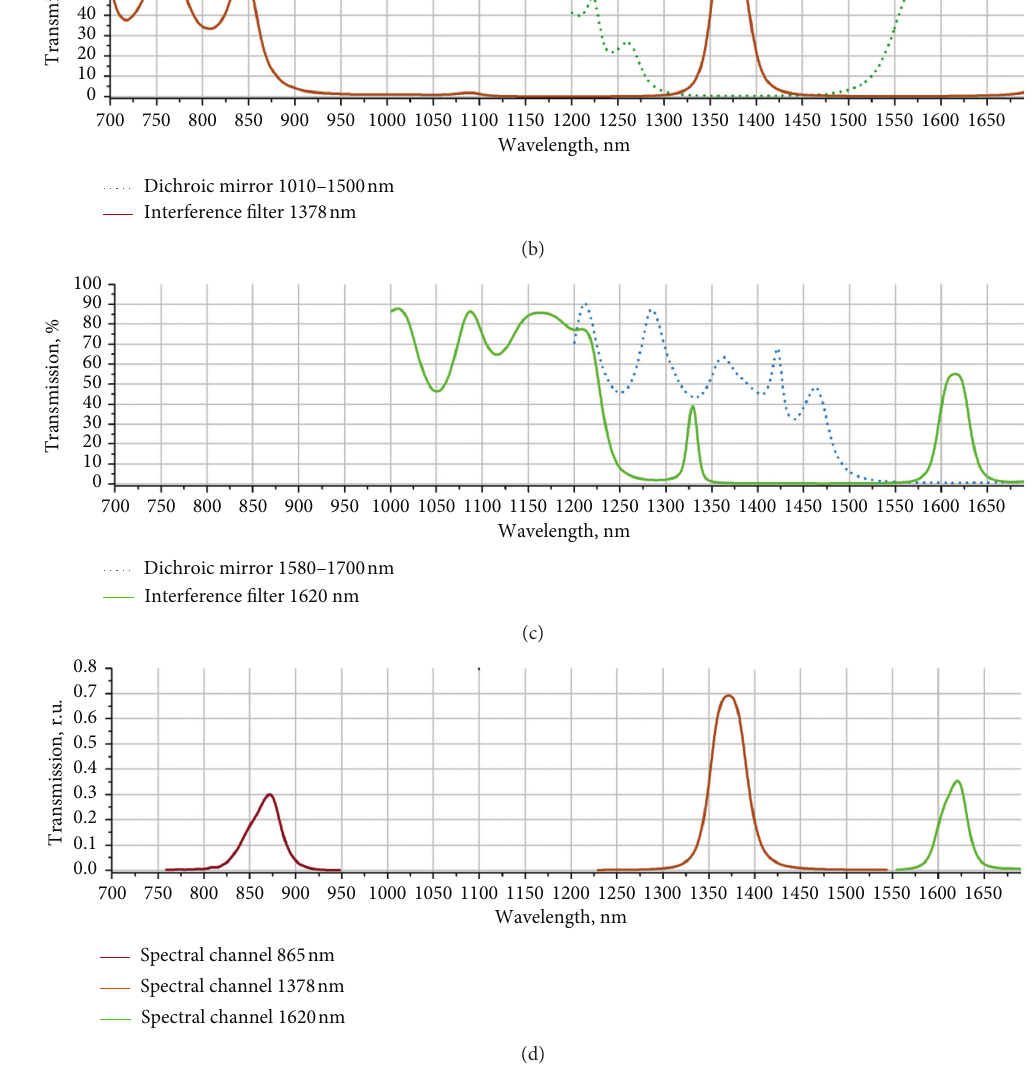
Figure 4: Characteristics of the individual dichroic mirrors and spectral filters and the resulting characteristics for spectral channels 865nm, 1378nm, and 1620nm of the optical units